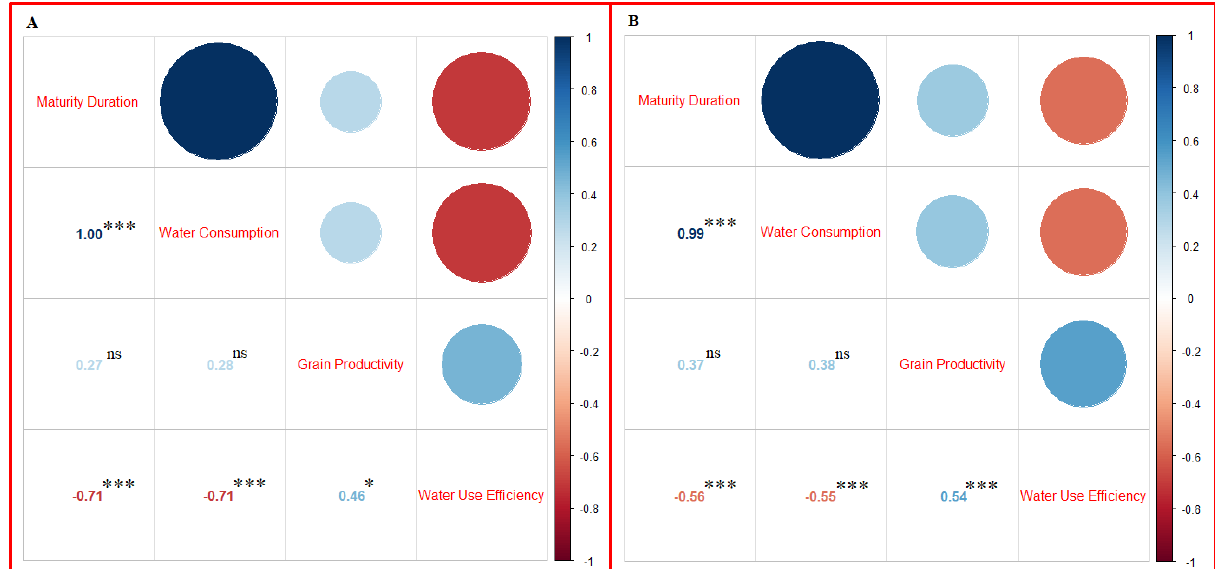
Figure 4. Correlation among maturity duration, water consumption, grain productivity and water use efficiency obtained under control ( A ) and drought stress treatment ( B ). Blue and red color indicates positive and negative correlation, respectively. Higher or lower correlation among parameters is linked to the color intensity and the size of the circles. ***: p < 0.001, *: p < 0.05, ns: non-significant difference.